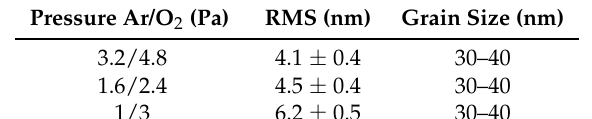
Figure 12. Example of Atomic Force Microscopy (AFM) results of a deposited film. Table 3. Surface roughness (RMS) and grains size calculated from the AFM analysis.